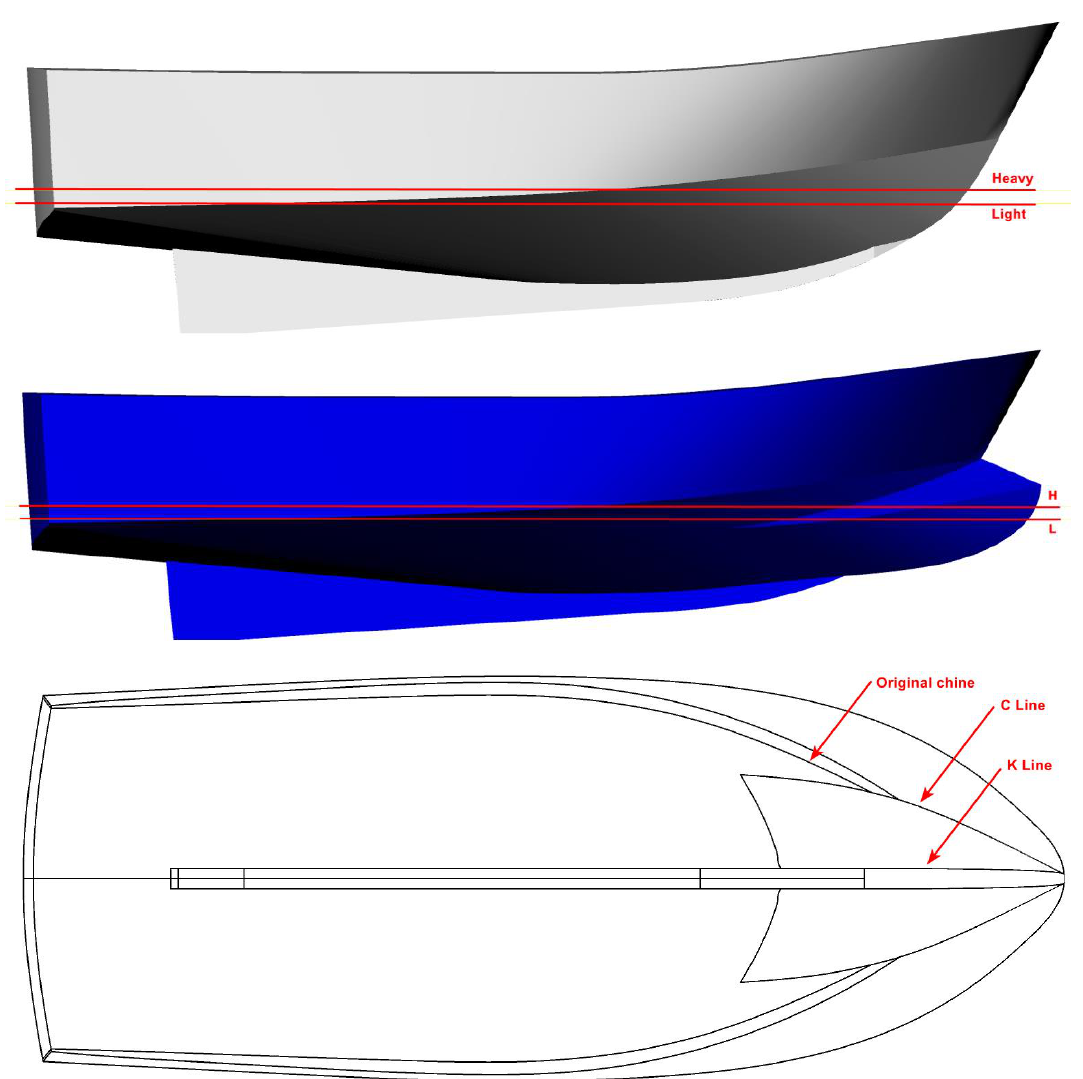
Figure 14. Unrolled dihedral bow of FAO4.